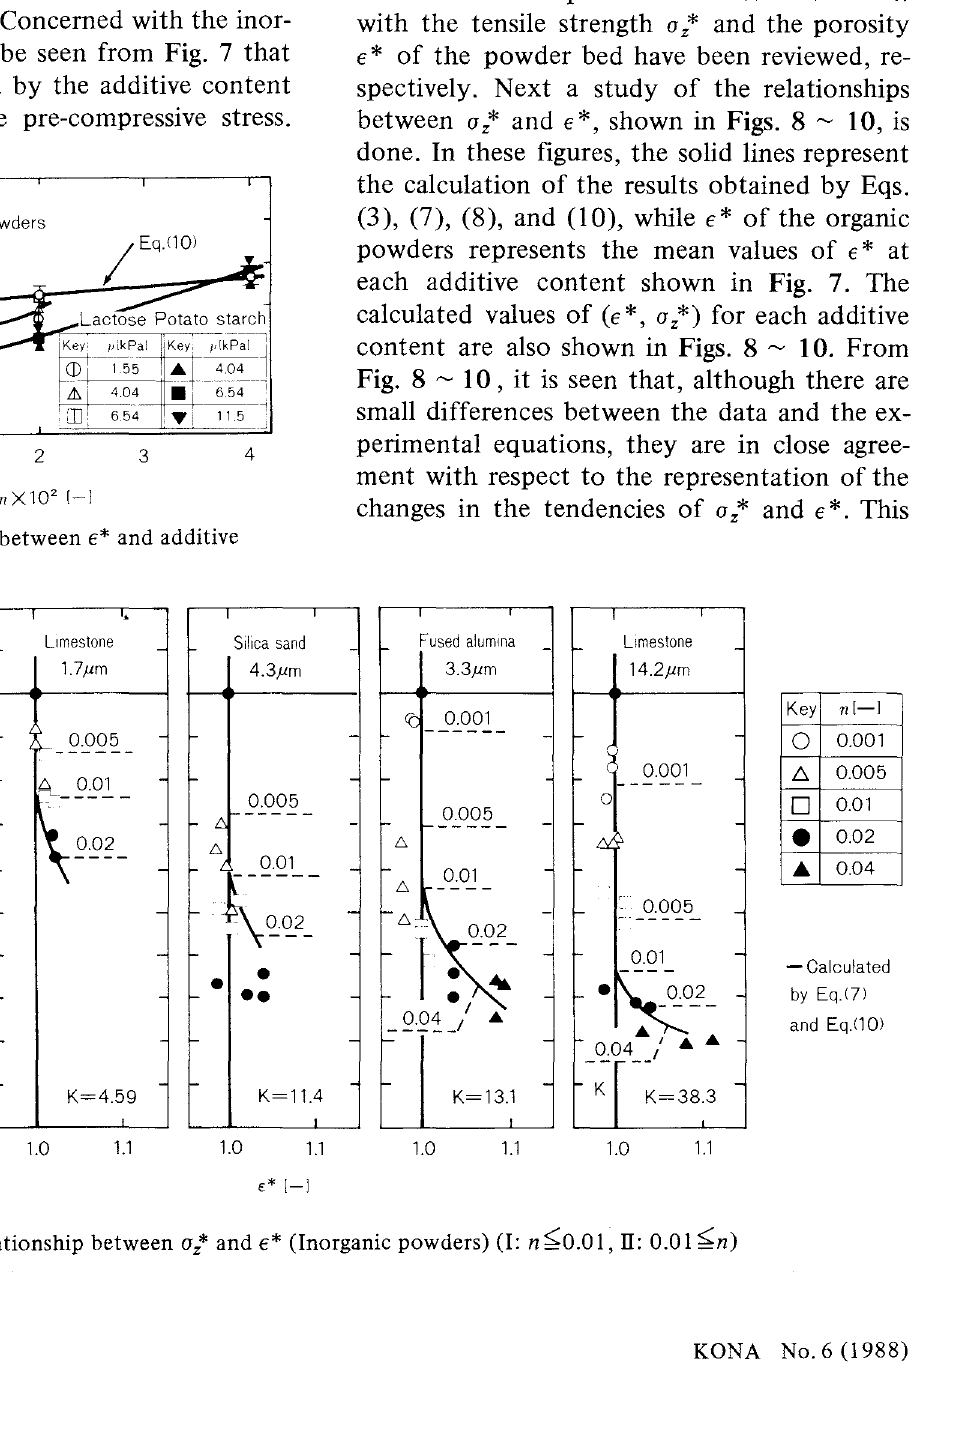
Fig. 7 Relationship between E* and additive